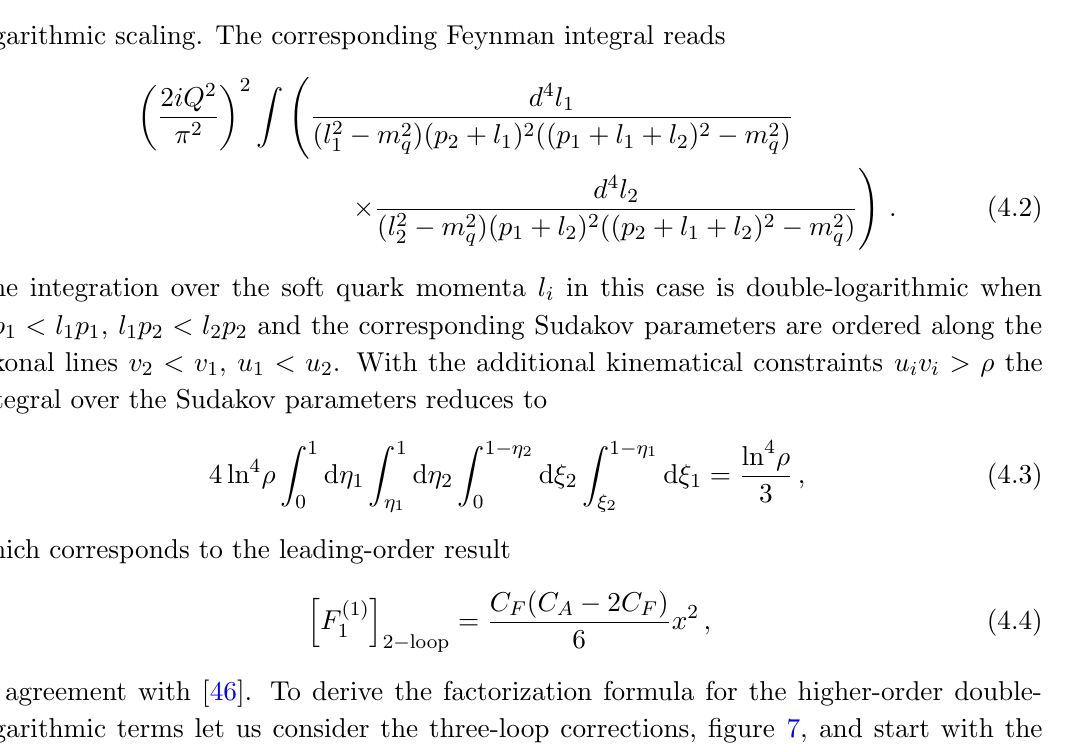
Figure 7 . The three-loop diagrams contributing to the vector form factor F (1) logarithmic approximation. Symmetric diagrams are not shown. The remaining diagrams either do not have the double-logarithmic integration region or have vanishing color